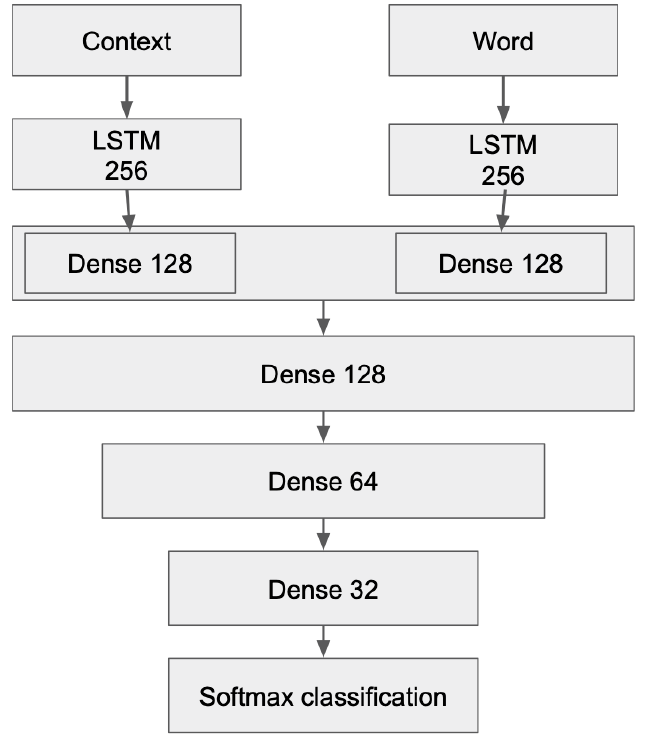
Figure 5 : DL architecture used for descriptor identification.